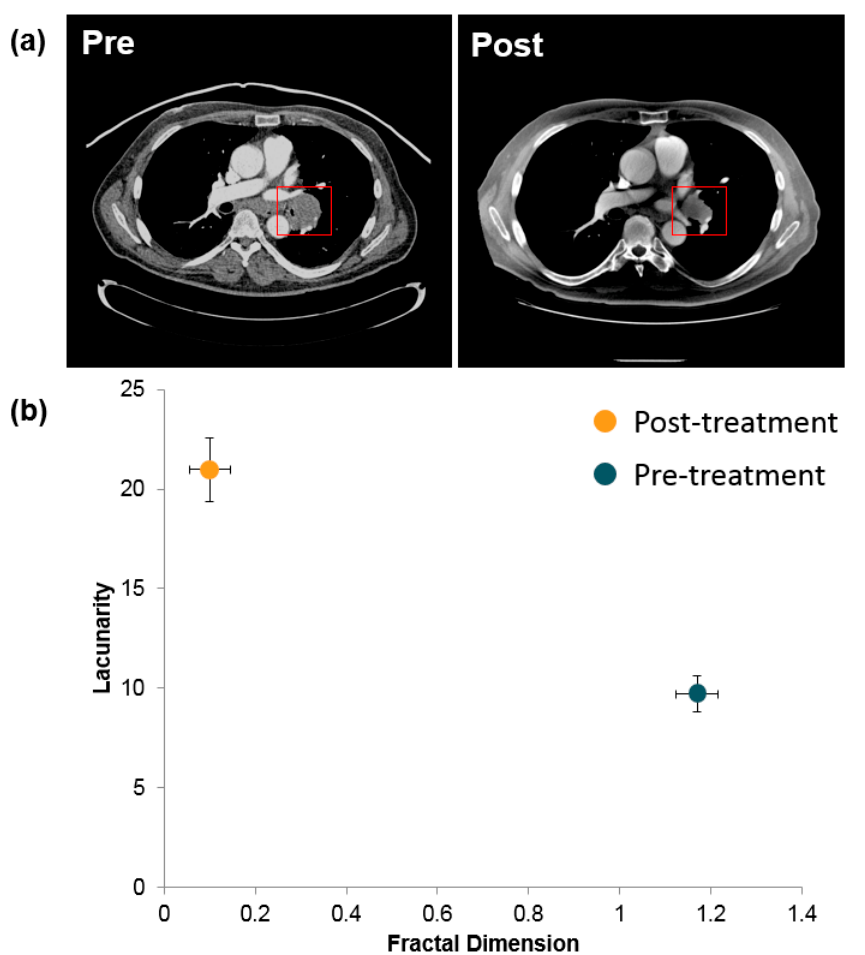
Figure 1. Lung CT images of a patient diagnosed with small cell lung carcinoma. ( a ) Pre- and post-CT images of the patent obtained before and after treatment. These images were loaded in Image J (Version 1.49), converted to 8 bit, and binarized; the background was set to white. The region of interest containing the tumor was defined manually. ( b ) Fractal dimension and lacunarity of primary small cell lung cancer (SCLC) tumors of three patients before and after treatment. The fractal dimension and lacunarity were calculated via the FracLac plugin (Box size was set from 0 pixels to 45% of image size, with 12 grid start positions using the grayscale differential scan). Significance was determined via t-test ( p < 0.05).